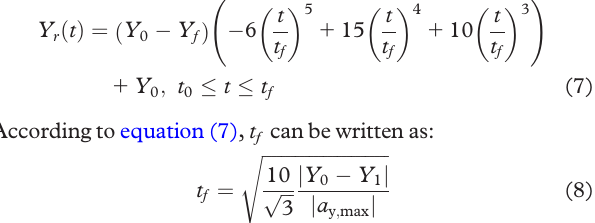
ffiffiffiffiffiffiffiffiffiffiffiffiffiffiffiffiffiffiffiffiffiffiffiffiffiffiffi